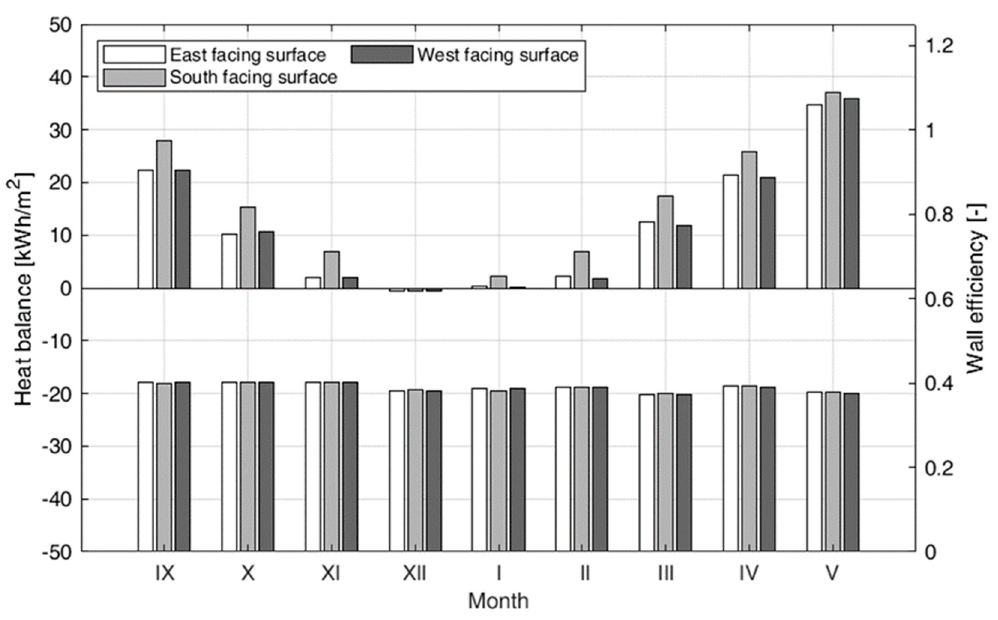
Figure 12. Comparison of monthly thermal balances (top) and thermal efficiency (bottom) of the SW- with the insulation thickness of 108 mm in the case of di ff erent orientations (location in